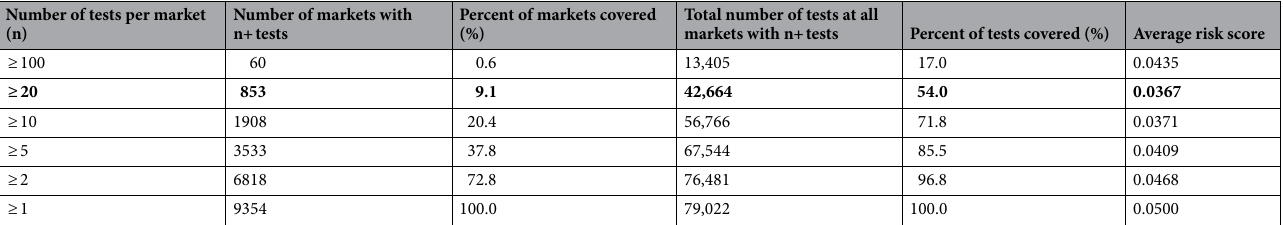
Table 2. Clustering results: number of markets identified and distribution of tests per market. The first column represents different inclusion thresholds for markets to be included in the analysis as per the number of tests associated with the respective market. The 2nd to 5th columns provide statistics on the markets included in the group: number of markets in the group, the fraction these markets out of all markets, the total number of tests associated with markets in the group, the fraction these tests out of all tests and the average risk score of the markets in the group. For example, if we choose markets that have at least 100 tests (first row), then only 0.6% of all markets and 17% of all tests will be covered in our analysis. Selected markets are in